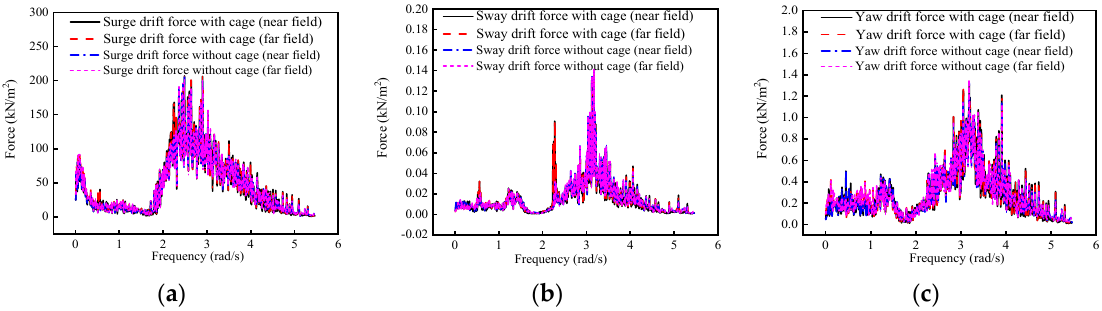
Figure 10. Comparison of second-order drift force results for the barge-type FOWT-AC and FOWT in the near and far fields: ( a ) Comparison of second-order surge drift force; ( b ) Comparison of second-order sway drift force; ( c ) Comparison of second-order yaw drift force.